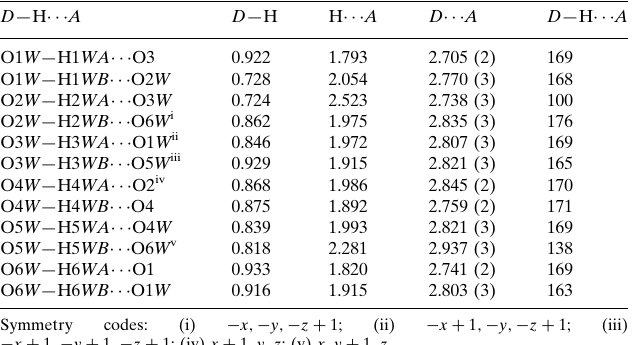
Hydrogen-bond geometry (A˚ , (cid:2)